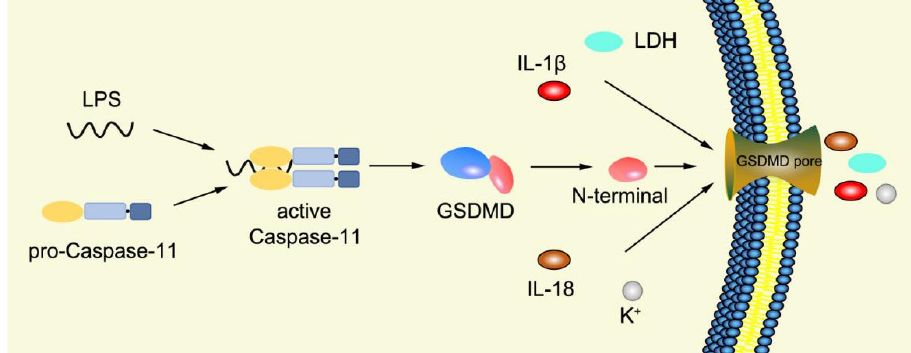
Figure 4. Mechanism of noncanonical pyroptosis pathway.